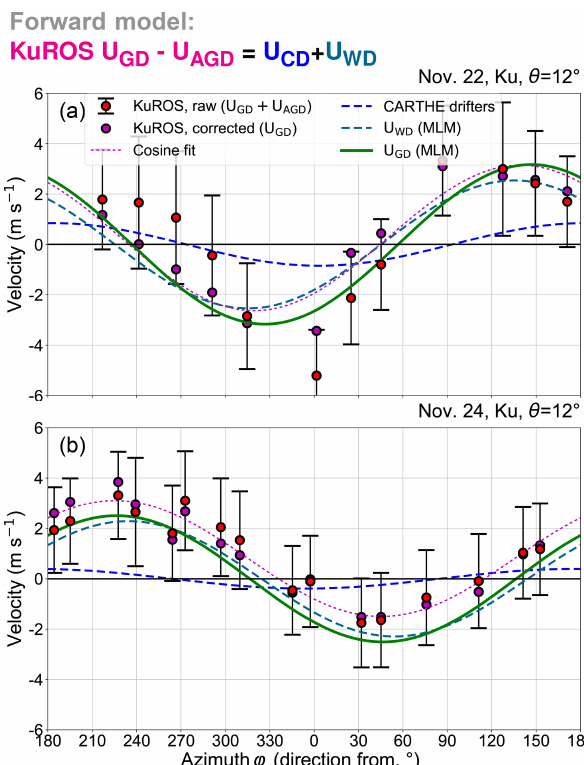
Figure 15. Ku-band Doppler measurements performed on (a) 22 November and (b) 24 November with the KuROS radar in the port-looking antenna configuration at a θ = 12 ◦ incidence angle. The graphical conventions are identical for the two plots. The red dots and error bars represent the average and ± 1 standard deviation interval of the platform-motion-corrected DV measurements along the different tracks. The magenta dots mark the mean values after correction of the U AGD contribution. The ma- genta dotted line is the cosine fit to the corrected data. The blue and midnight blue lines respectively represent the projection along the line-of-sight azimuth of the CARTHE current measurements and the U WD vector computed from the MLM-processed Trèfle buoy data. The green line represents the sum of these two contributions and should agree with the magenta dotted line.